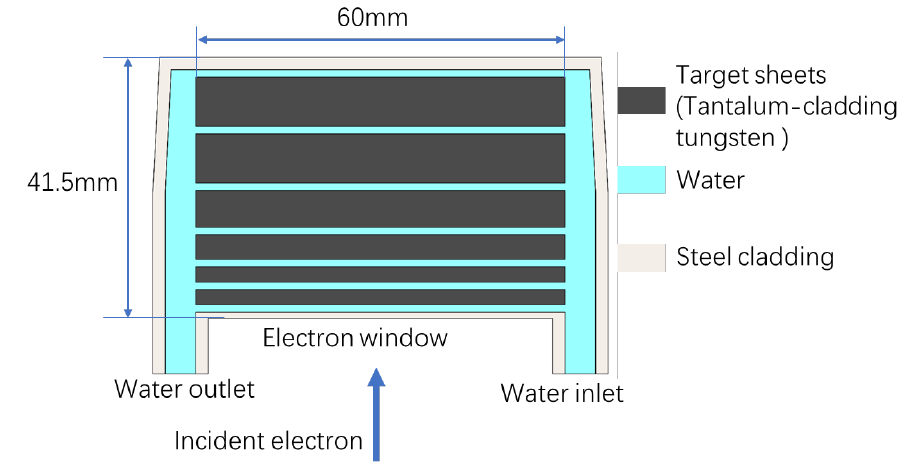
Figure 5. The schematic diagram of the neutron target.